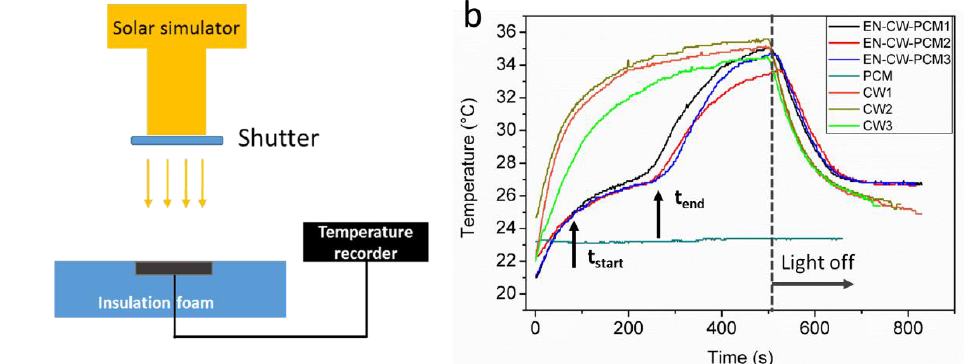
Figure 5. ( a ) Scheme of solar-to-thermal conversion measurement setup; ( b ) The temperature changes of EN-CW–PCM and CW, repeated 3 times, respectively, and PCM under 500 s of 1 sun solar irradiation (1000 W/m 2 ) and cooling down. Table 2. Solar-to-thermal conversion efficiency.